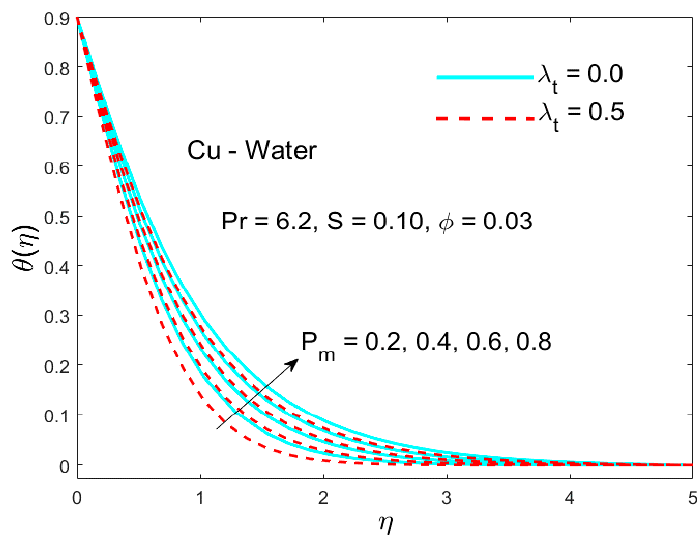
ff ect of P m on the temperature field. Figure 5. Effect of m P on the temperature field. Figure 5. E